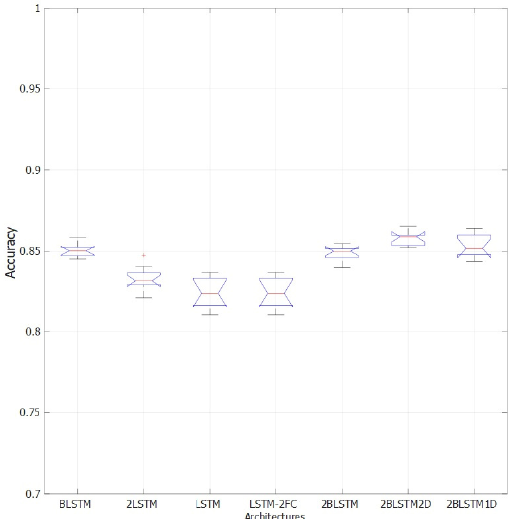
Figure 6. Accuracy distribution over 30 repetitions of 50-epochs training for different network architectures and dropout fixed at 45%. Tested architectures: one hidden bidirectional LSTM layer (BLSTM), two LSTM layers (2LSTM), one LSTM layer (LSTM), one LSTM layer followed by two fully connected layers (LSTM-2FC), two bidirectional LSTM layers (2BLSTM), two bidirectional LSTM layers with two dropout layers (2BLSTM2D), two bidirectional LSTM layers with one dropout layer (2BLSTM1D). Observations beyond the whisker length are marked as outliers and they are represented with “+” symbol.